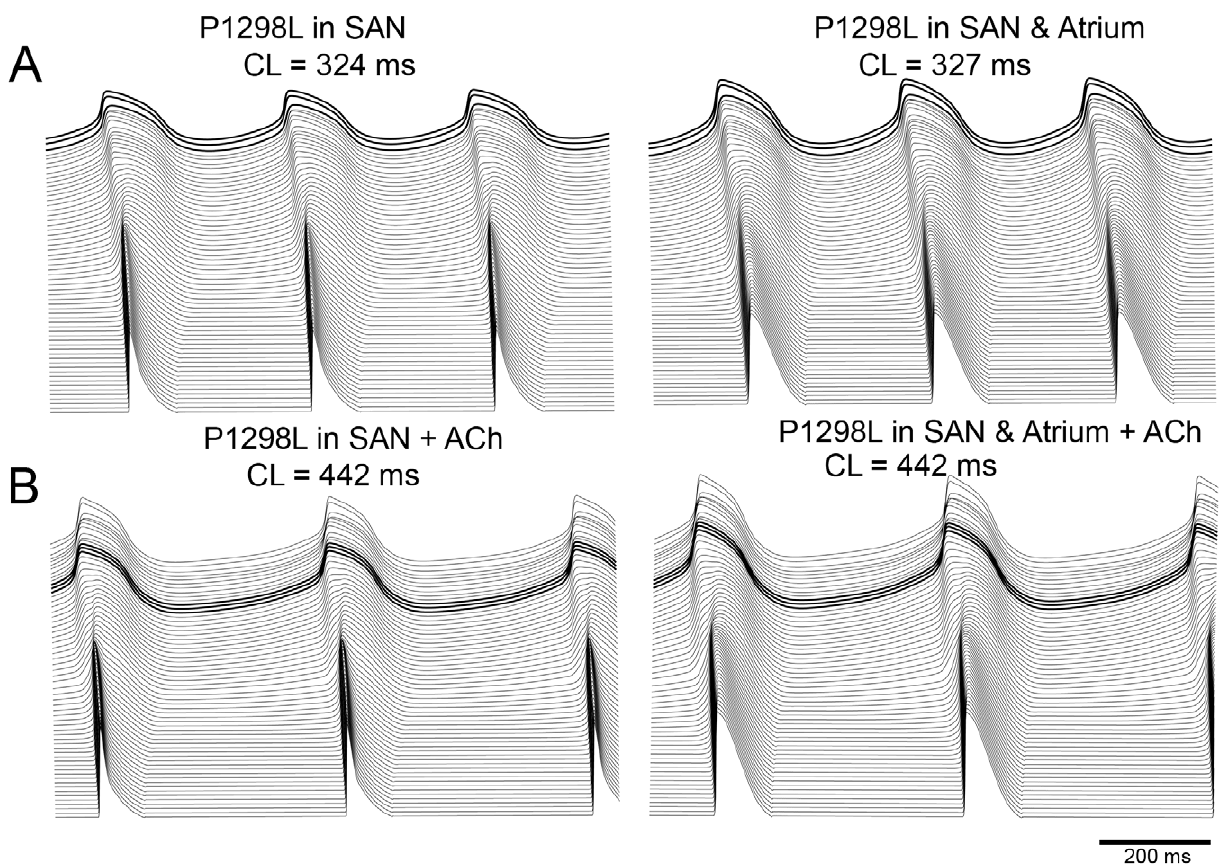
Figure 8. The effects of the familial sick sinus syndrome (SSS) Na + channel mutation P1298L in the mosaic model. Figure 8A and B: Simulations after incorporation of the P1298L sodium mutation with and without vagal stimulation in the mosaic model are shown. The left panels of A and B show the effect of the mutation on interspersed atrial cells within the SAN alone. The right panels show the effect when the mutation is also incorporated into atrial cells.